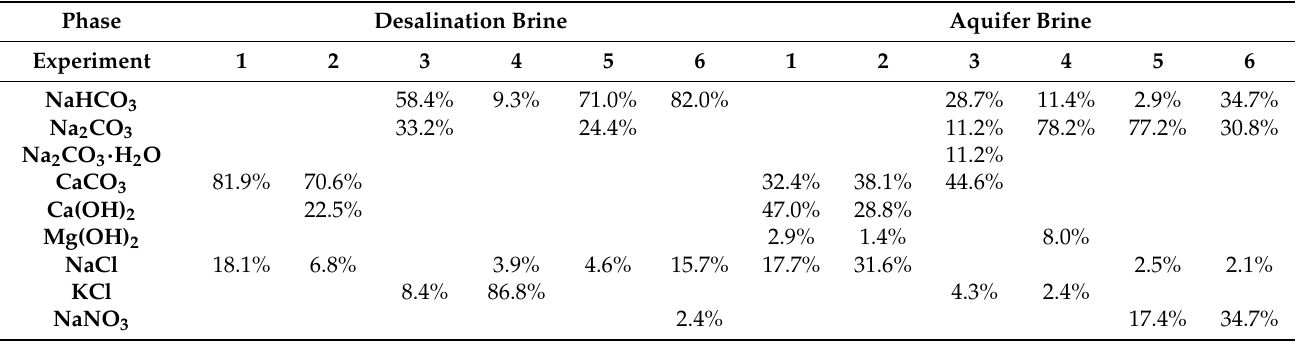
Table 1. Mineral composition (wt%) of obtained precipitates, determined by the Rietveld refine- ment in HighScore Plus. For each sample, values sum to 100 wt% based on the combination of identified/quantified